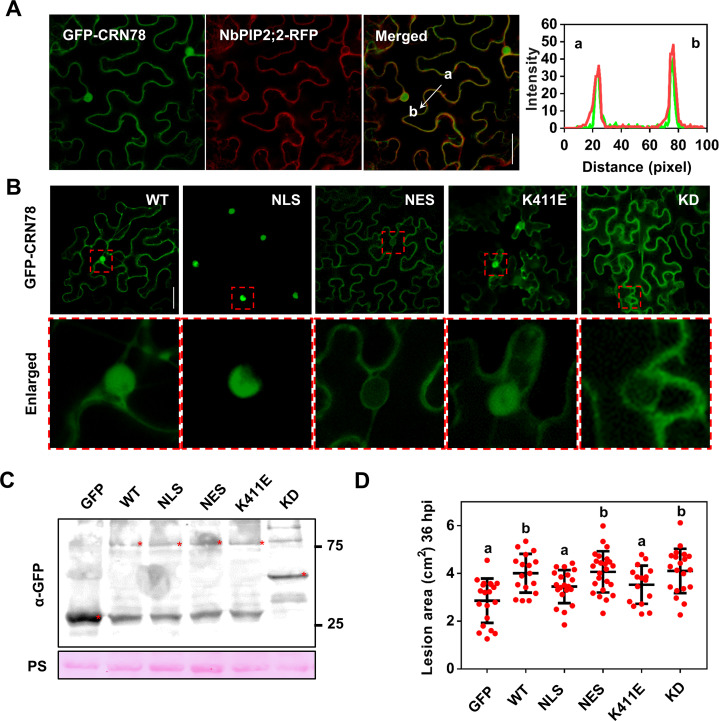
The localization of CRN78 on plasma membrane is required for CRN78 virulence.(A) Co-localization of GFP-CRN78 and NbPIP2;2-RFP. Confocal microscopy images were taken at 48 hours post infiltration. Scale bars = 50 μm. (B) Subcellular localization of GFP-CRN78 and the mutants. Confocal microscopy images were taken at 48 hours post infiltration. Detailed subcellular localization has been shown below. WT: GFP-CRN78WT; NLS: GFP-CRN78NLS; NES: GFP-CRN78NES; K411E: GFP-CRN78K411E; KD: GFP-CRN78KD. Scale bars = 50 μm. (C) Immunoblot analysis. The α-GFP antibody was used to detect expression of the indicated constructs. Equal loading of each sample is indicated by Ponceau staining of the Rubisco protein. (D) Lesion areas of leaves expressing GFP, CRN78 or the mutants upon P. capsici infection. Lesion areas were calculated from three independent biological replicates using at least five leaves per replicate. Dots denote individual lesion area from each infection site (mean ± SD; n > = 16, Student’s t-test, P < 0.01).